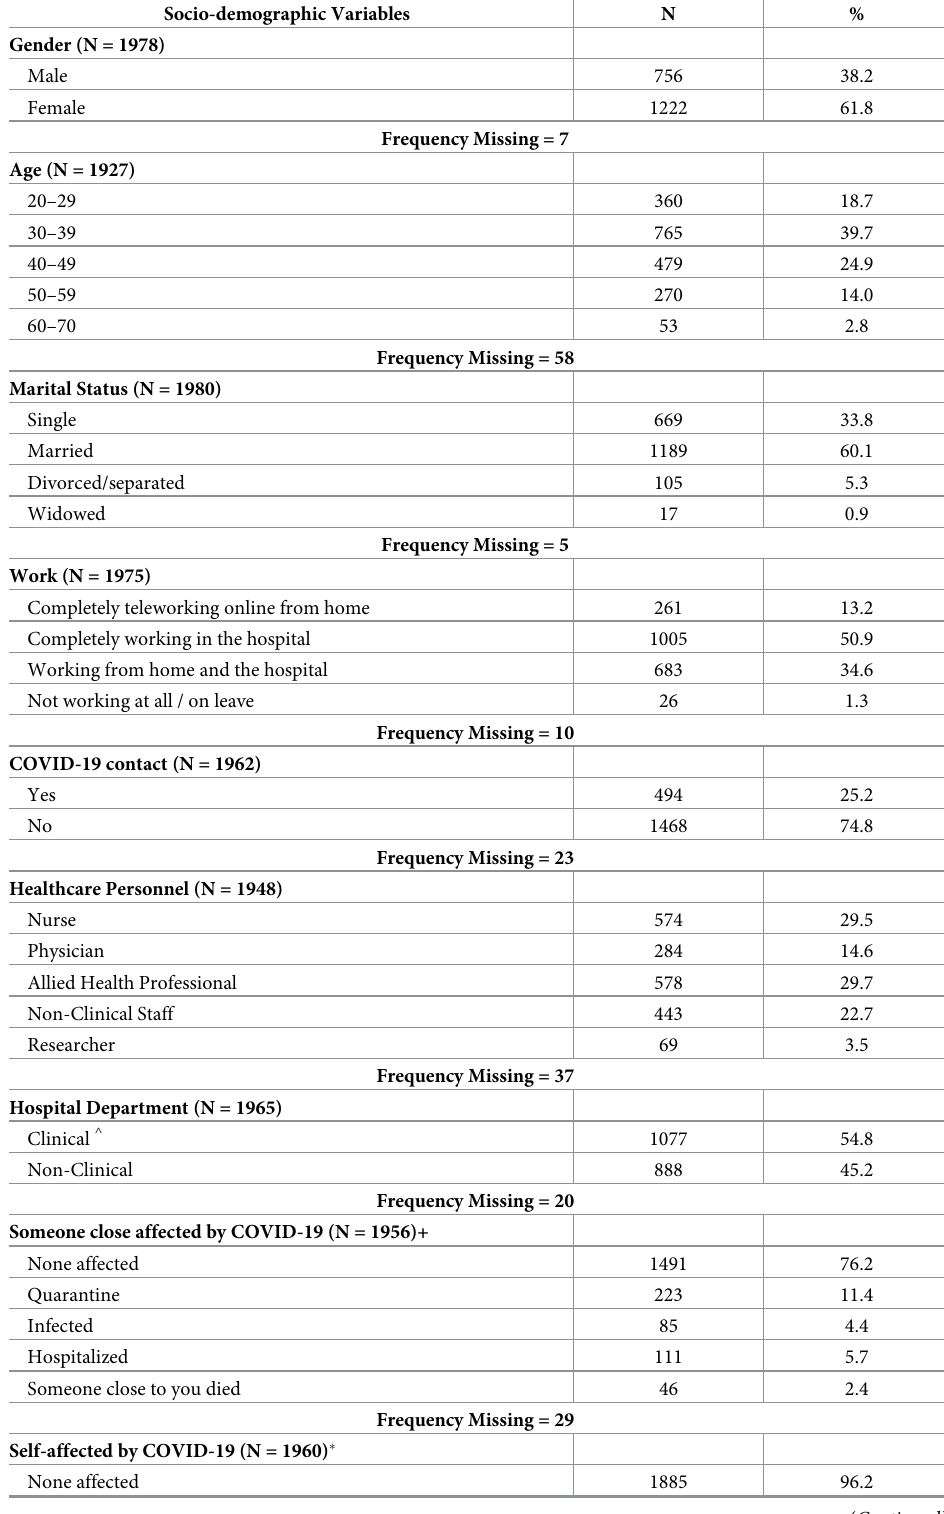
Table 1. Sample demographics and COVID-19